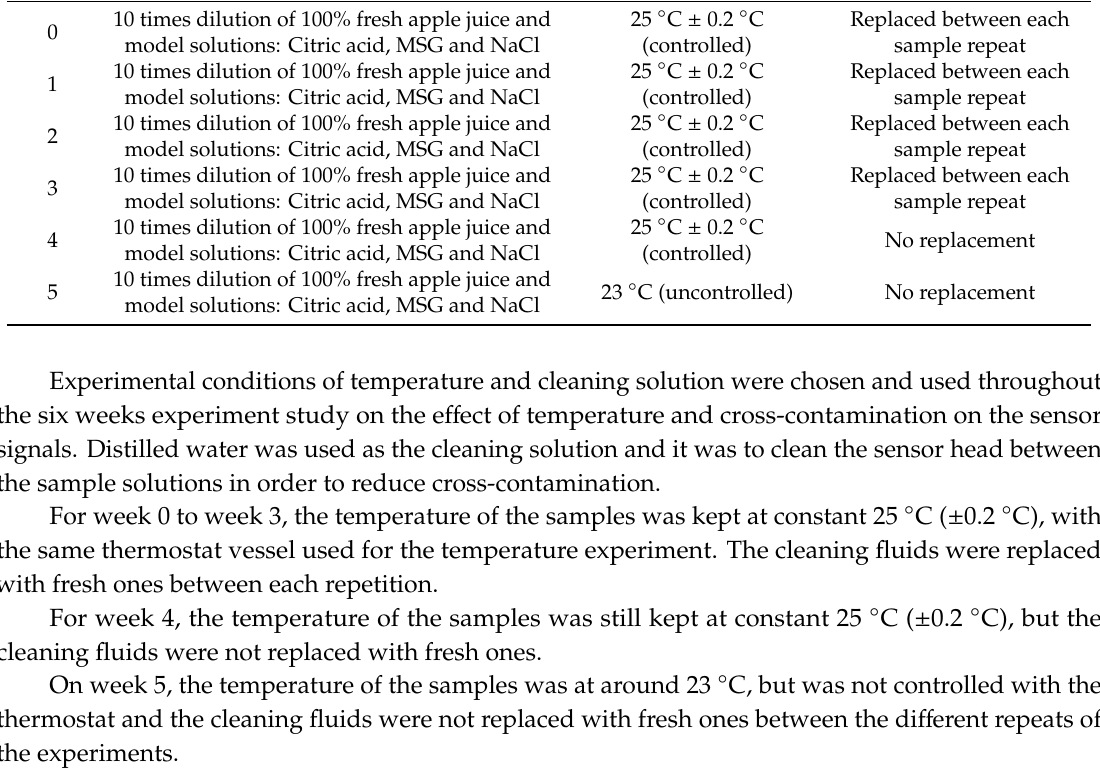
Experimental Conditions